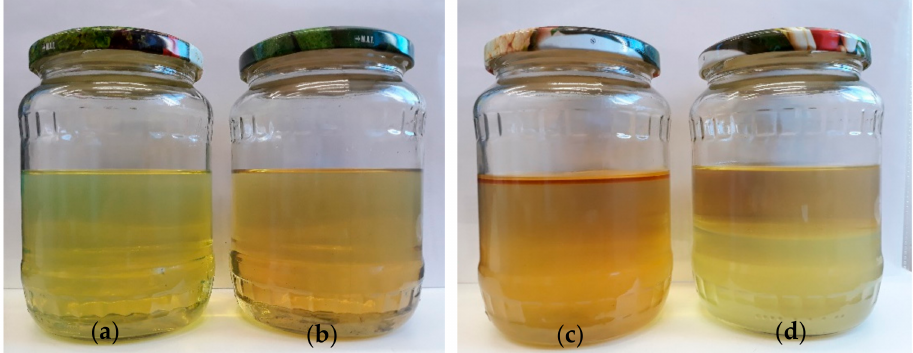
Figure 1. Test fuel blends: ( a ) D100, ( b ) M5, ( c ) M10, ( d ) M20.